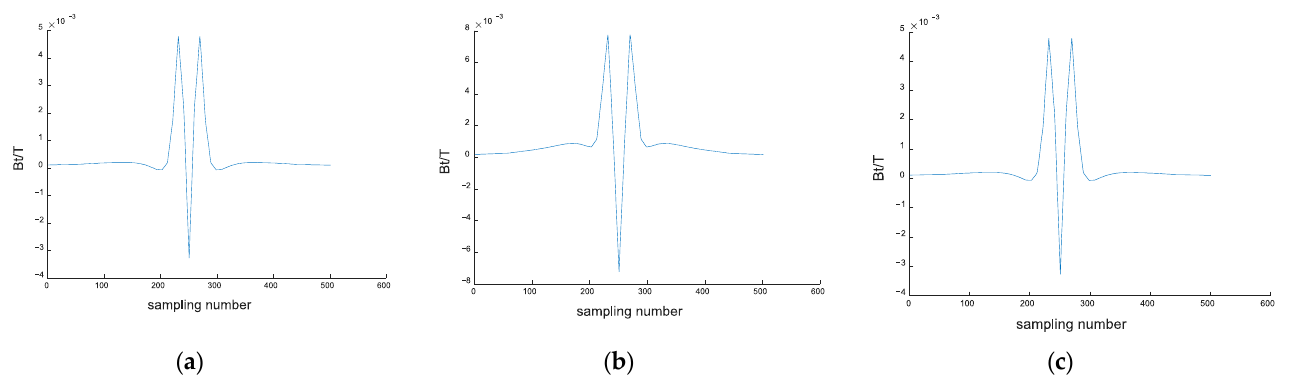
Figure 7. Scan path of transverse crack.